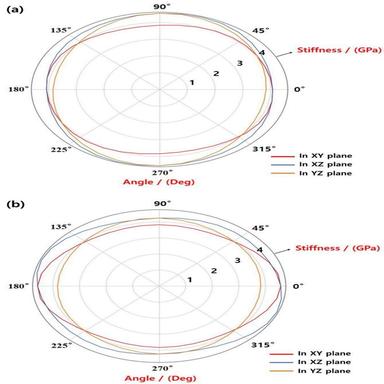
2D representation of Young's modulus (E) in the XY, XZ, and YZ planes for the (a) longitudinal and (b) transverse specimens.